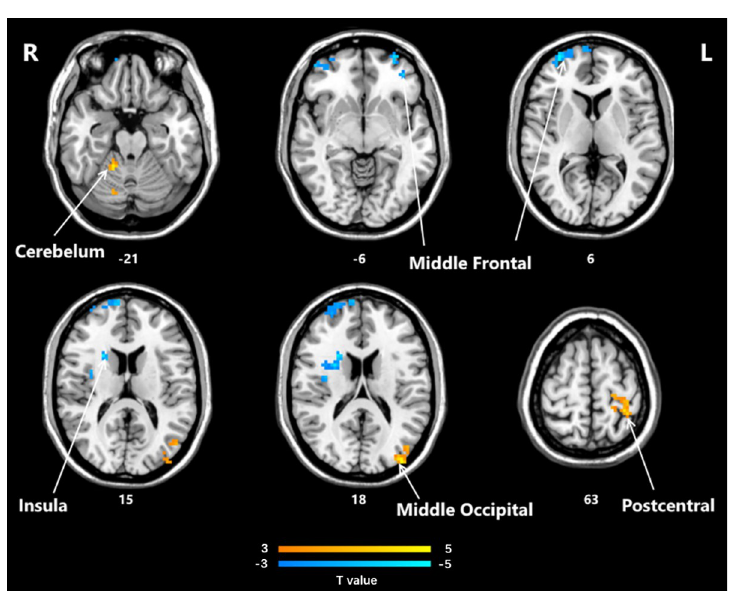
Fig 7. Brain regions that showed significant alterations in ReHo values before and after sham stimulation (P < 0.05, AlphaSim corrected). The yellow color denotes post-sham-HD-tDCS > pre-sham-HD-tDCS in the ReHo values and the blue color denotes post-sham stimulation < pre-sham stimulation. The T-value bars are shown at the bottom. The brain regions with significant increases in ReHo values include Frontal Mid R, Frontal Mid Orb L, Insula R. However, Cerebellum 4 5 R, Occipital Mid L, and Postcentral L decreased significantly. ReHo, regional homogeneity; HD-tDCS, high-definition transcranial direct current stimulation.